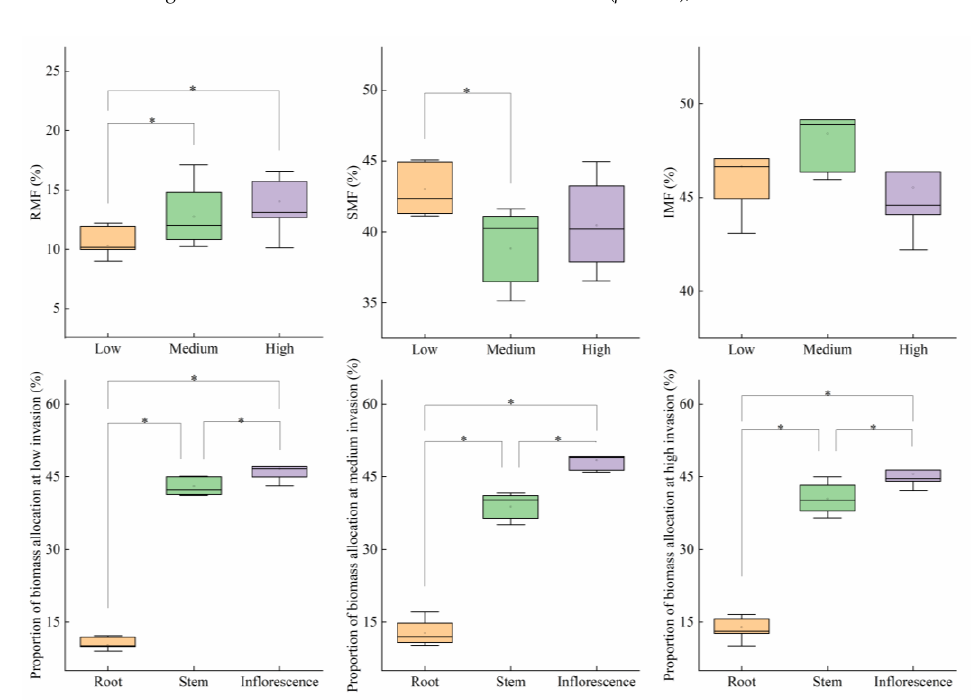
Figure 1. Differences in biomass allocation in different structures of Pedicularis kansuensis in different invasion levels. * indicates a significant difference ( p < 0.05).